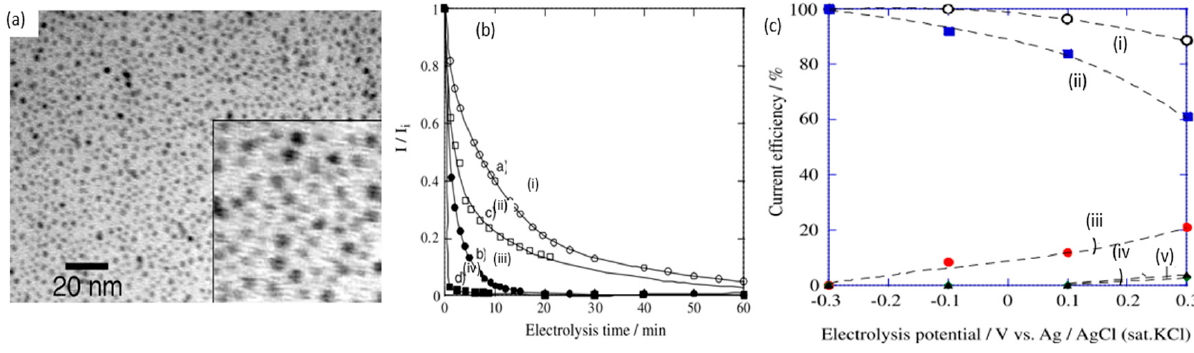
Figure 9. ( a ) TEM image of AuNP capped with decanethiolate monolayer shell (for deposition on electrode). ( b ) Change in current ratios across time with gold nanoparticles in alkali medium (i), bulk gold in alkali medium (ii), gold nanoparticles in neutral medium (iii), and bulk gold in neutral medium (iv). ( c ) Plots of electrolysis products with 2 nm AuNP in 0.1 M NaOH, 0.01 M glucose, at different potentials (vs. Ag/AgCl); total current efficiency of all products (i), gluconolactone (ii), oxalate (iii), glyconate (iv), formate (v). Reprinted with permission from Ref. [59]. Copyright 2005, Electrochemistry Communications.